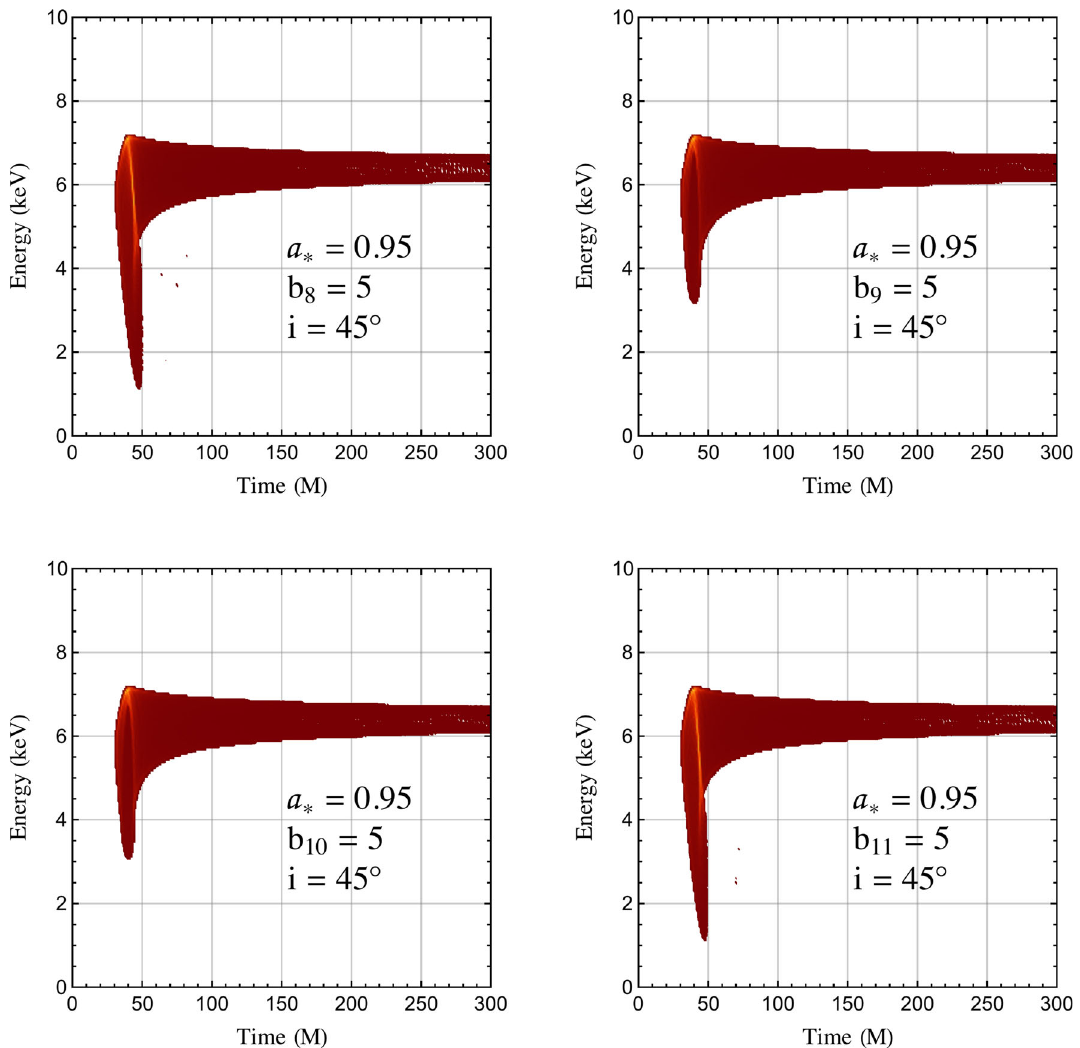
Fig. 2 Reverberation mapping measurement associated with iron line in GB spacetime. Impact of the parameters b 8 (top left panel), b 9 (top right panel), b 10 (bottom left panel), b 11 (bottom right panel) on the 2D transfer function. See the text for more